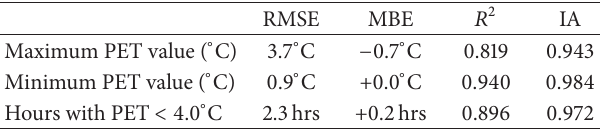
Table 5: Statistical indices for the evaluation of the forecasting ability of the developed ANN no. 2 forecasting model. One day ahead prognosis. Cold period of